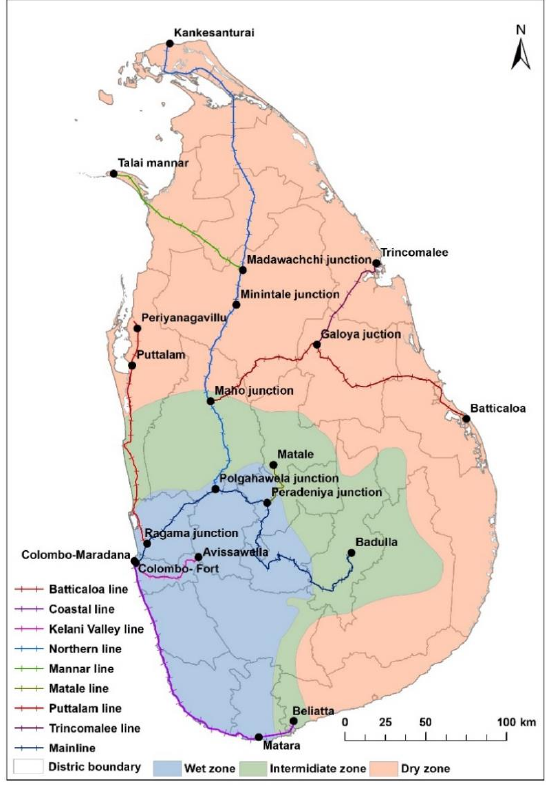
Figure 1. Study area with the railway network of Sri Lanka.